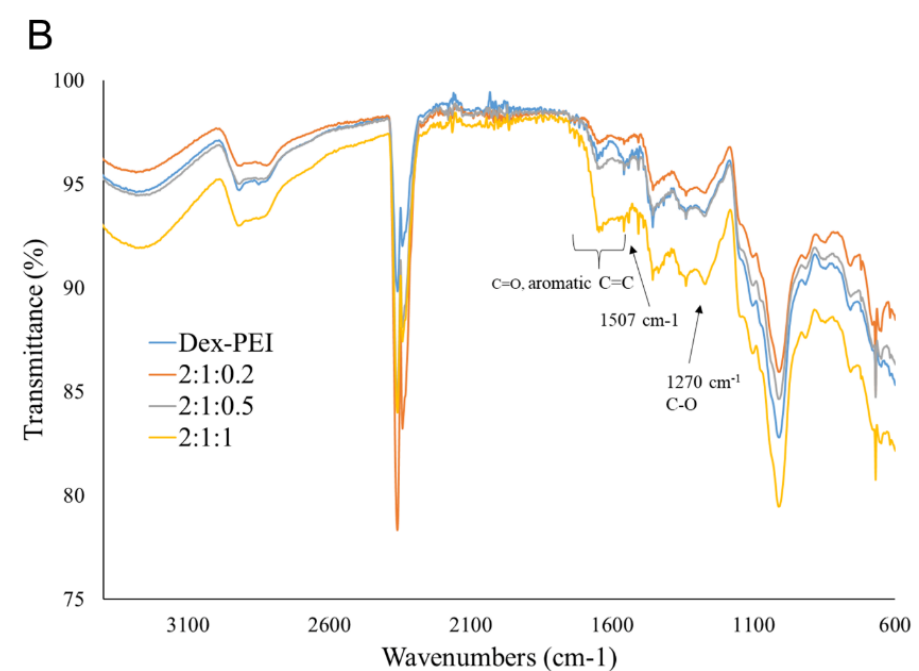
Figure 3. FTIR spectra of ( A ) dex-PDA with feed ratios ranging 2:1–2:0.2 (dextran hydrogel has no PDA present) and ( B ) dex-PEI-PDA with feed ratios ranging 2:1:1–2:1:0.2 (dex-PEI hydrogel has no PDA present).